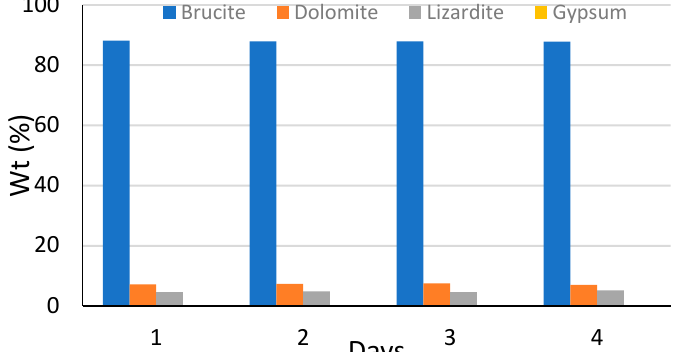
Figure 3. The quantitative results of XRD analysis, regarding the presence of crystalline phases in the coating samples during the acid spraying test application.